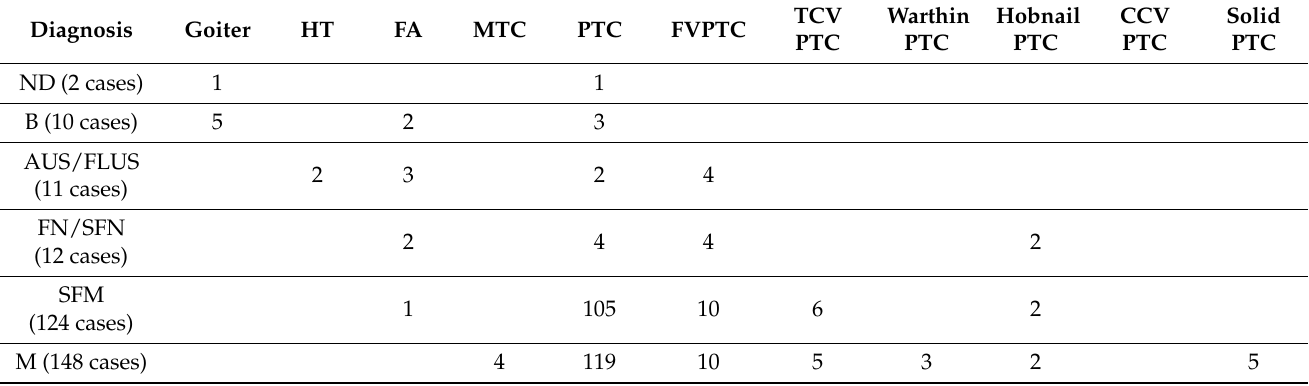
Table 4 summarizes the histological diagnoses that were rendered in 386 equal to or larger than 1 cm cases, which were comprised of 261 (67.6%) benign and 125 (32.3%) malignant lesions. Surgical follow-up stratified according to different cytological categories is shown in Table 4. The four ND cases (out of 29) that underwent surgery were diagnosed as either three goiters or one FVPTC. For 182 (out of 226) benign cases that had surgical follow-up, they were diagnosed as goiter ( n = 145), FA ( n = 31), Hashimoto thyroiditis (HT)